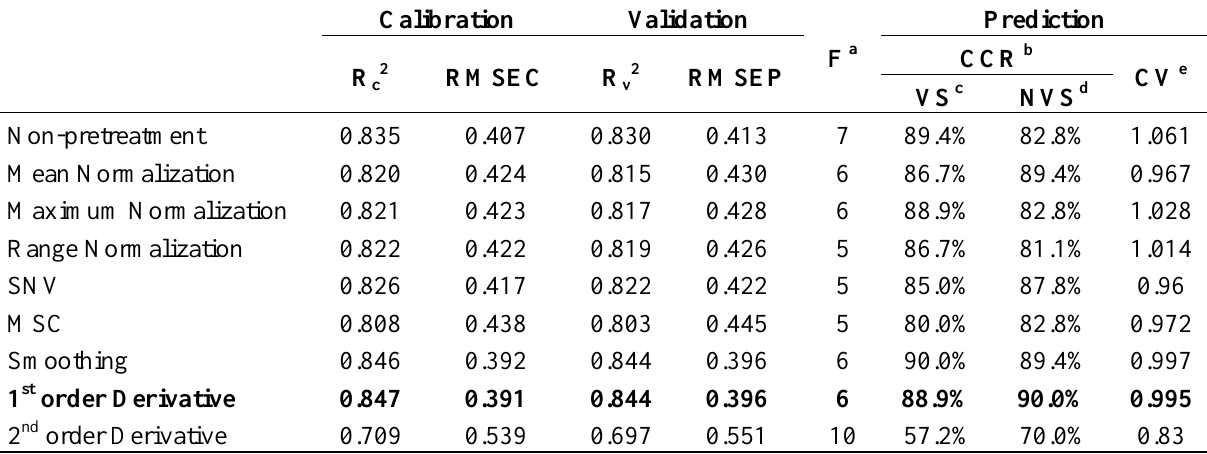
Table 3. Results obtained using the PLS-DA models based on the reflectance spectra with RL illumination (600–700 nm).